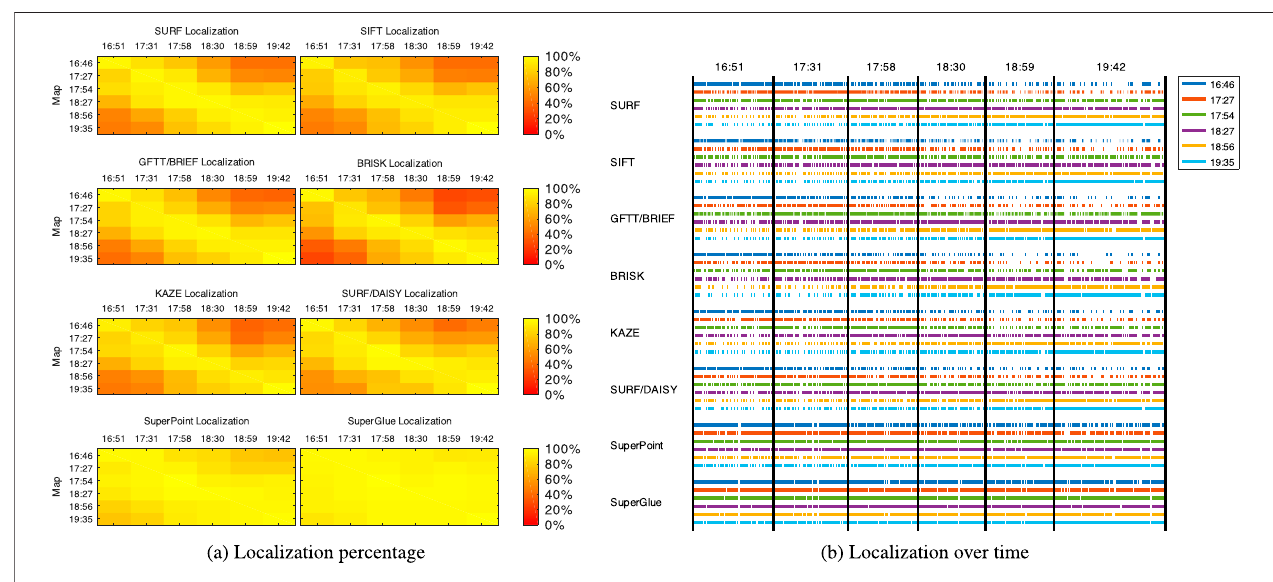
FIGURE 4 | Re-localized frames over time of the A to F localization sessions ( x -axis) over the 1 to 6 single-session maps ( y -axis) in relation to the visual features used: (A) re-localization percentage; (B) re-localization over time.